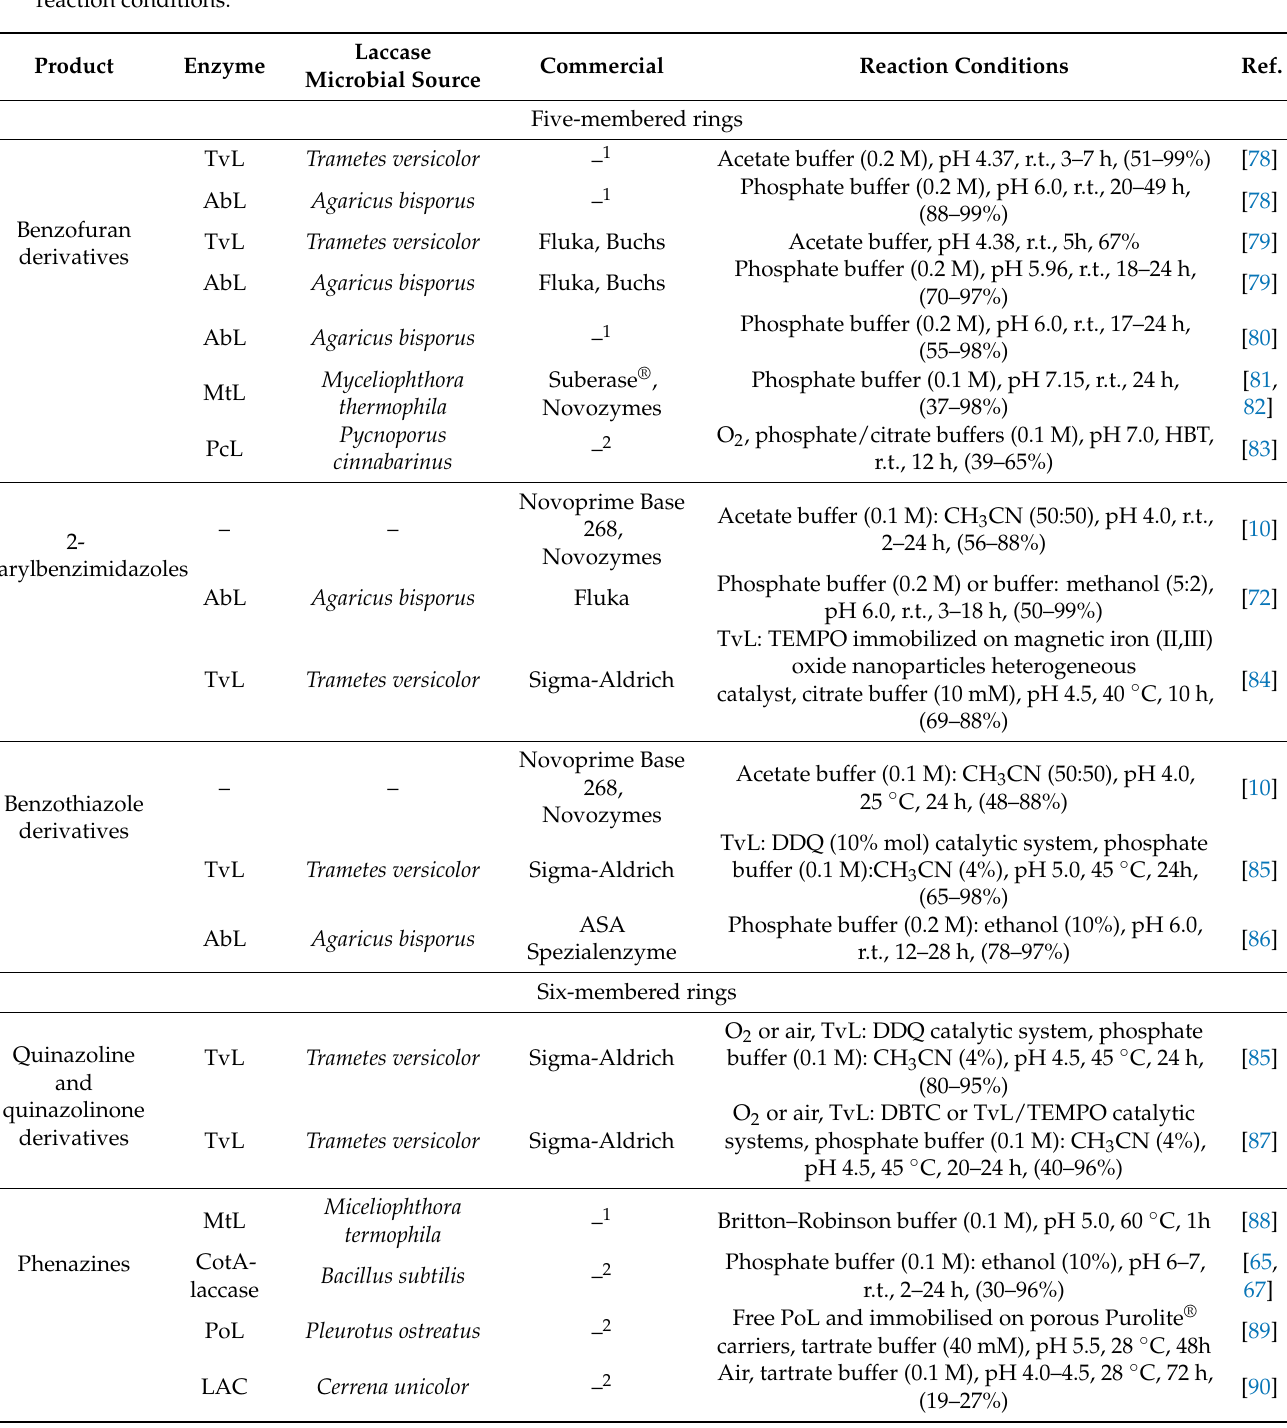
Table 1. Synthetic pathways for nitrogen- and oxygen-based heterocyclic compounds mediated by laccases at optimized reaction